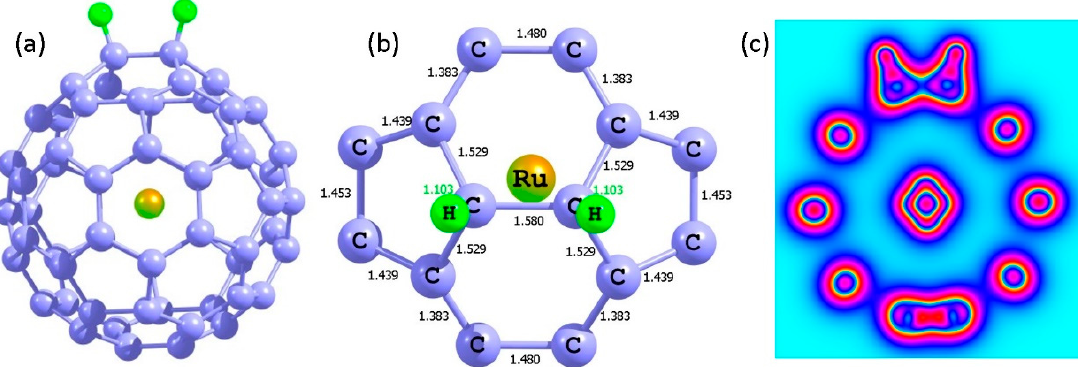
Figure 7. ( a ) Energy minimized structure of two hydrogen atoms adsorbed on the most stable site (66) of Ru@C 60 , ( b ) bond distances in the relaxed configuration and ( c ) charge density plot.